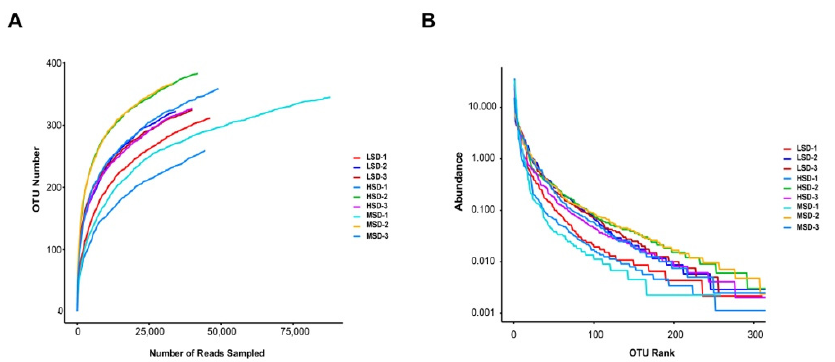
Figure 3. Diversity of the bacterial communities. ( A ) Chao estimator (Chao). ( B ) Shannon diversity index (Shannon). ( C ) Simpson diversity index (Simpson). ( D ) Coverage diversity index (Coverage). Date presented as mean ± SD.